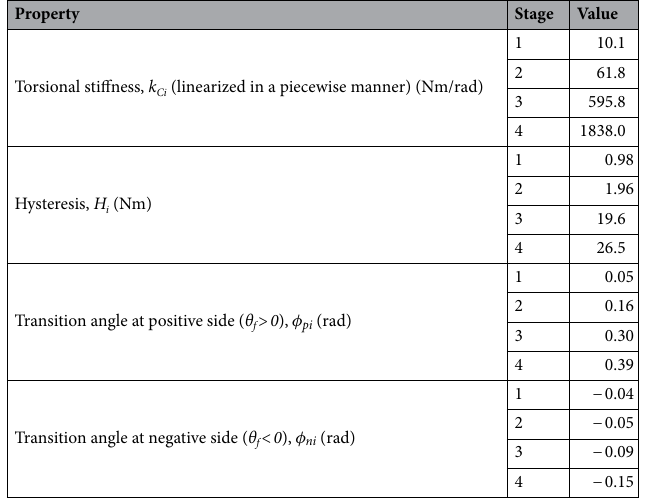
Table 1. Properties of the physical multi-staged clutch damper.